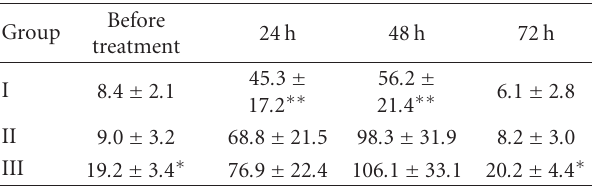
Table 3: Blood insulin levels before and after dexamethasone therapy ( x ± s